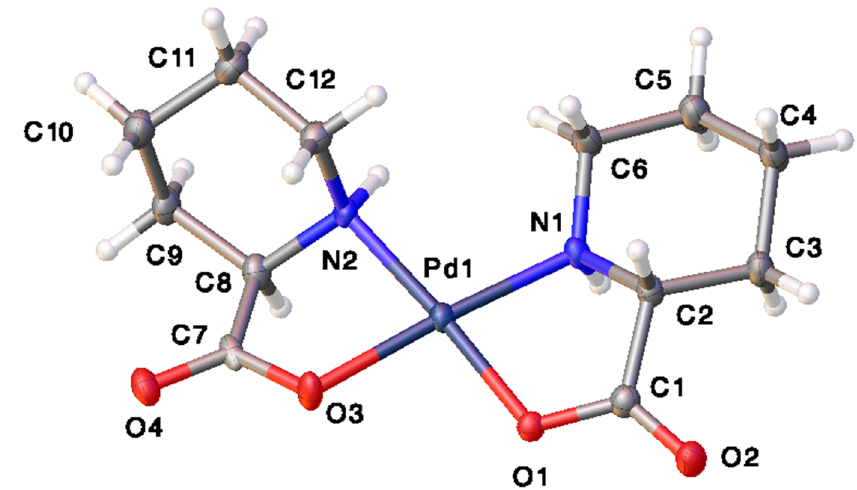
Figure 12. ORTEP plot of cis-bis(D-pipicolinato)palladium(II), ( 9 ). Lattice water molecules have been removed for clarity. Thermal ellipsoids are shown at the 50% probability level. CCDC:1913625.